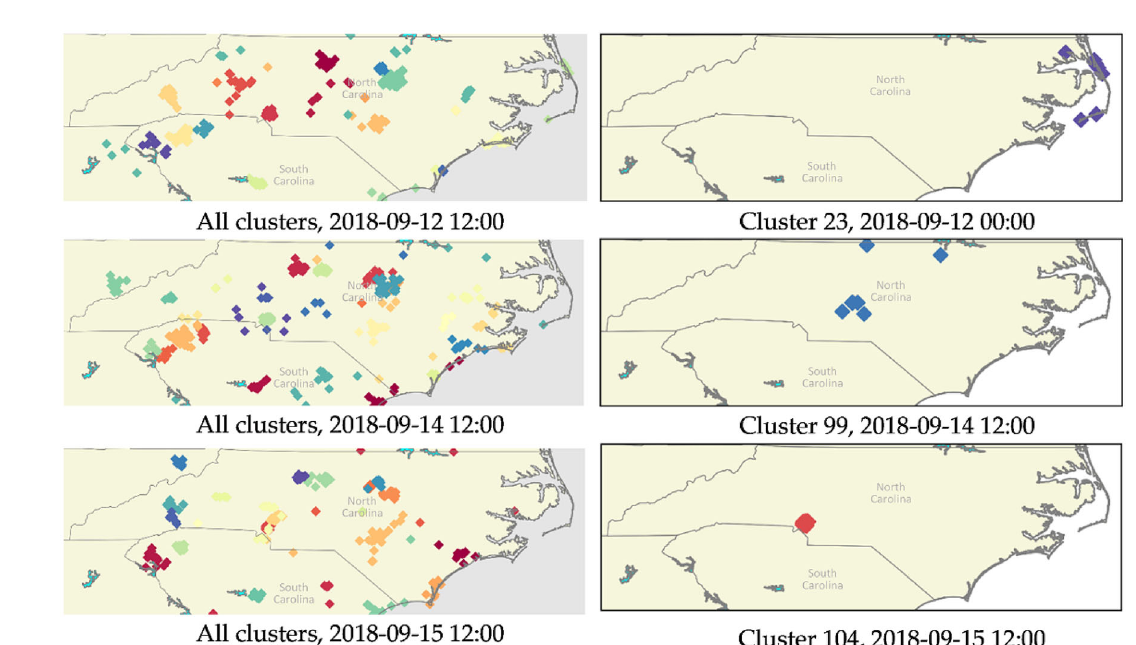
Fig. 2 Examples of tweet clusters with varied densities during Hurricane Florence in North and South Carolina (on each map, tweet clusters are highlighted with different